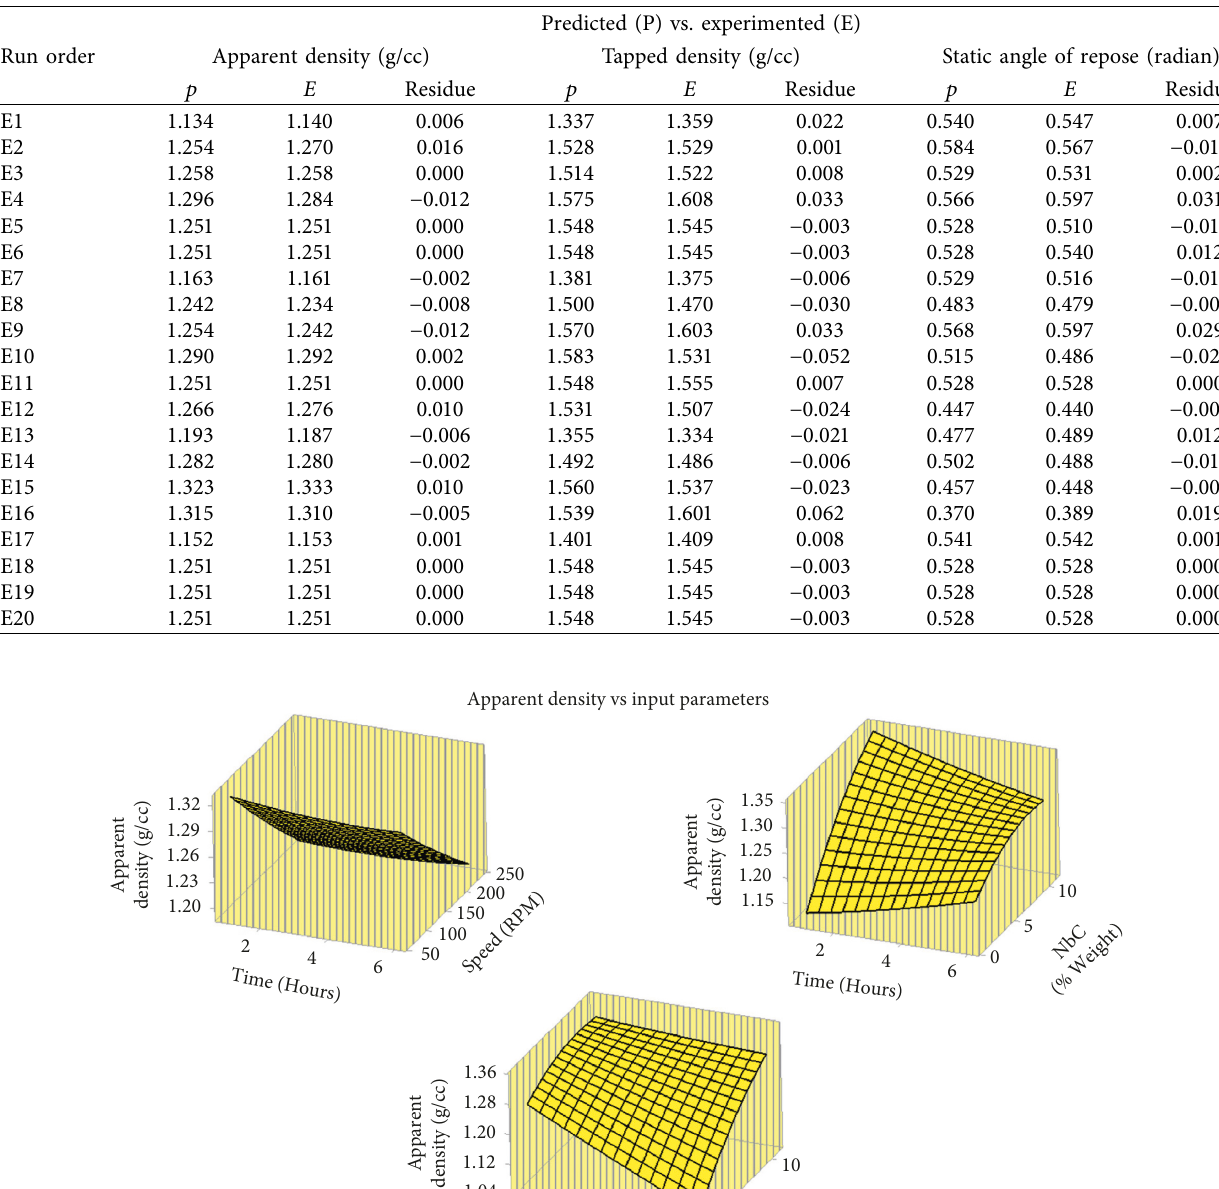
Table 5: Validation of regression